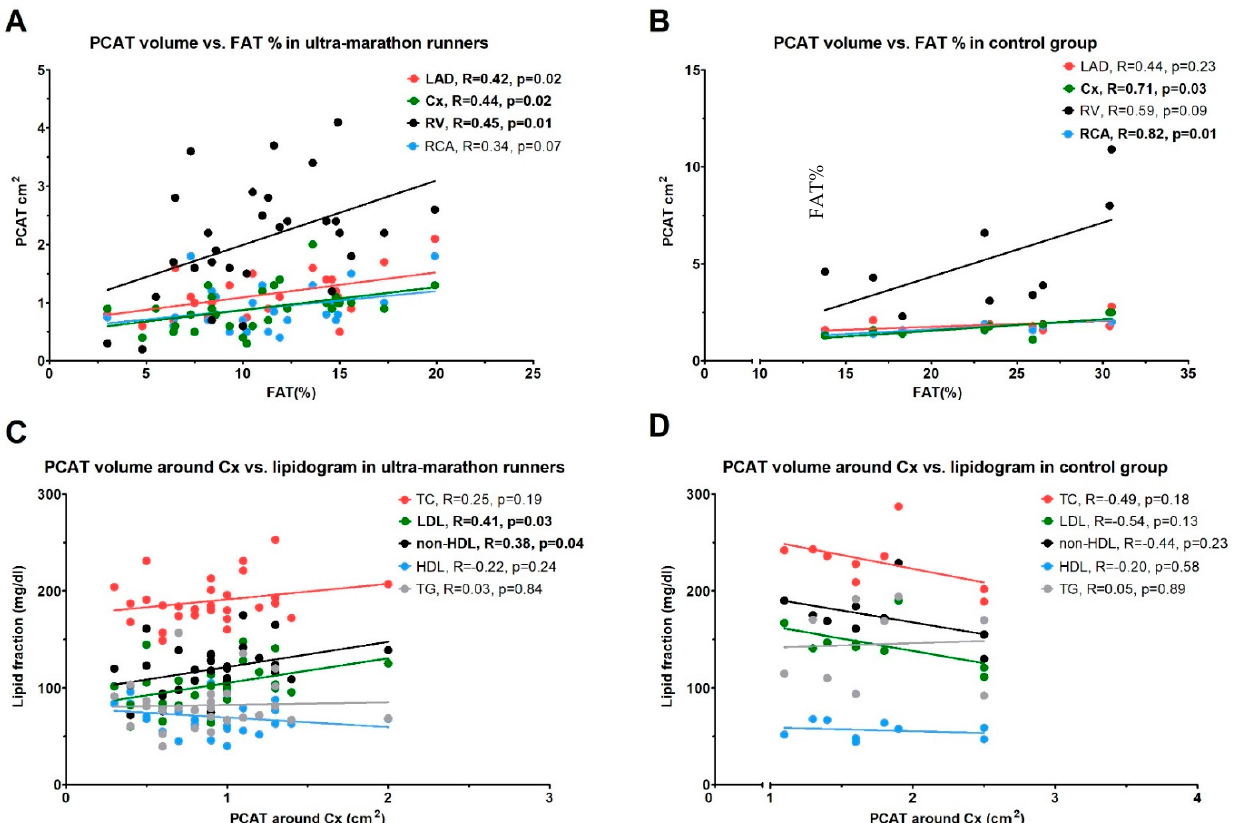
Figure 2. ( A , B ) Correlations between body fat percentage (FAT%) and pericoronary adipose tissue (PCAT) in the ultra- marathon runners and control group. ( C , D ) Correlations between PCAT around the circumflex artery (Cx) and lipidogram parameters. LAD—left anterior descending artery; RV—right ventricle; RCA—right coronary artery; LDL—low-density lipoproteins; HDL—high-density lipoproteins; non-HDL—non-high-density lipoproteins; TC—total cholesterol; TG—tri- glycerides.